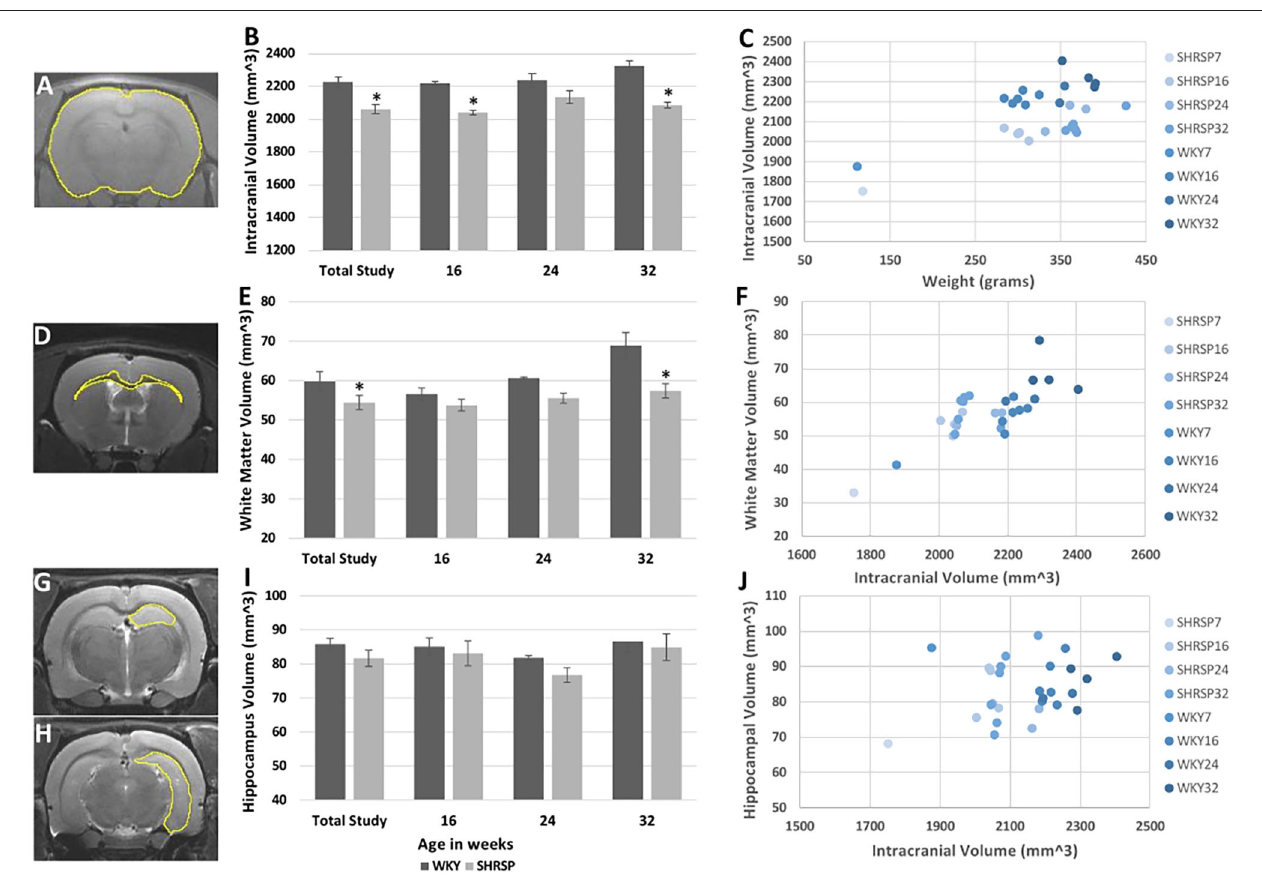
FIGURE 4 | Volumetric analyses of the intracranial (A–C) , white matter (D–F) , and hippocampal (G–J) volumes in WKY and SHRSP show smaller volumes in SHRSP compared to WKY. Manual segmentation of one slice is shown on T1 sequence for the intracranial content (A) , T2w imaging for the white matter (D) , and hippocampus (G,H) . The intracranial volume was statistically and significantly smaller in SHRSP compared to WKY in the total study and at the study time points (B) . White matter volume was statistically and significantly smaller in SHRSP in both the total cohort and at 32 weeks (E) . Finally, while the hippocampal volume was smaller in SHRSP, the difference was not statistically significant (I) . Scatter plot presentation of the data is presented in (C) , (F) , and (J) in which SHRSP and WKY at each time point is presented with a distinct color. Figure (C) shows the difference between SHRSP and WKY using intracranial volume (vertical axis) and weight (horizontal axis). A lesser difference is seen using white matter volume (vertical axis) with intracranial volume on the horizontal axis (F) . Finally, animals do not appear to be different according to the hippocampal volume (vertical axis) (J) . WKY, Wistar Kyoto Rats; SHRSP, Spontaneously Hypertensive Stroke-Prone Rats; * Statistically significant difference of P < 0.05. Data in (B) , (E) , and (I) represent the mean and standard error of the mean.